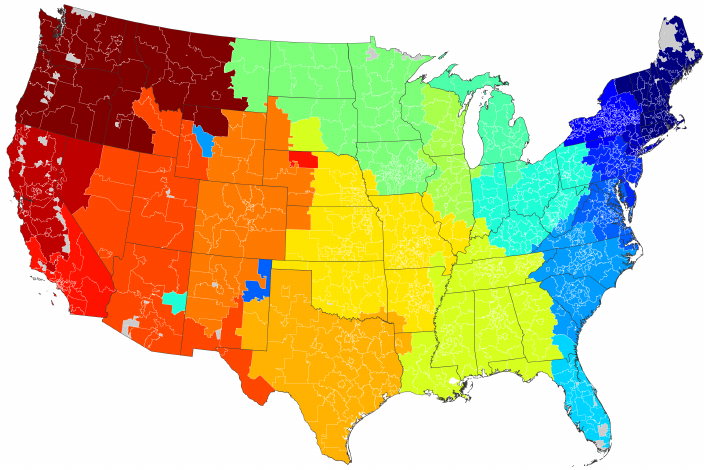
Figure 1: Division of the messaging network for the lower 48 states into 19 communities by modularity maximization using the Louvain algorithm (Blondel et al. 2004). Colors represent communities at the level of 3-digit zip codes. Gray regions are areas with no assigned zip